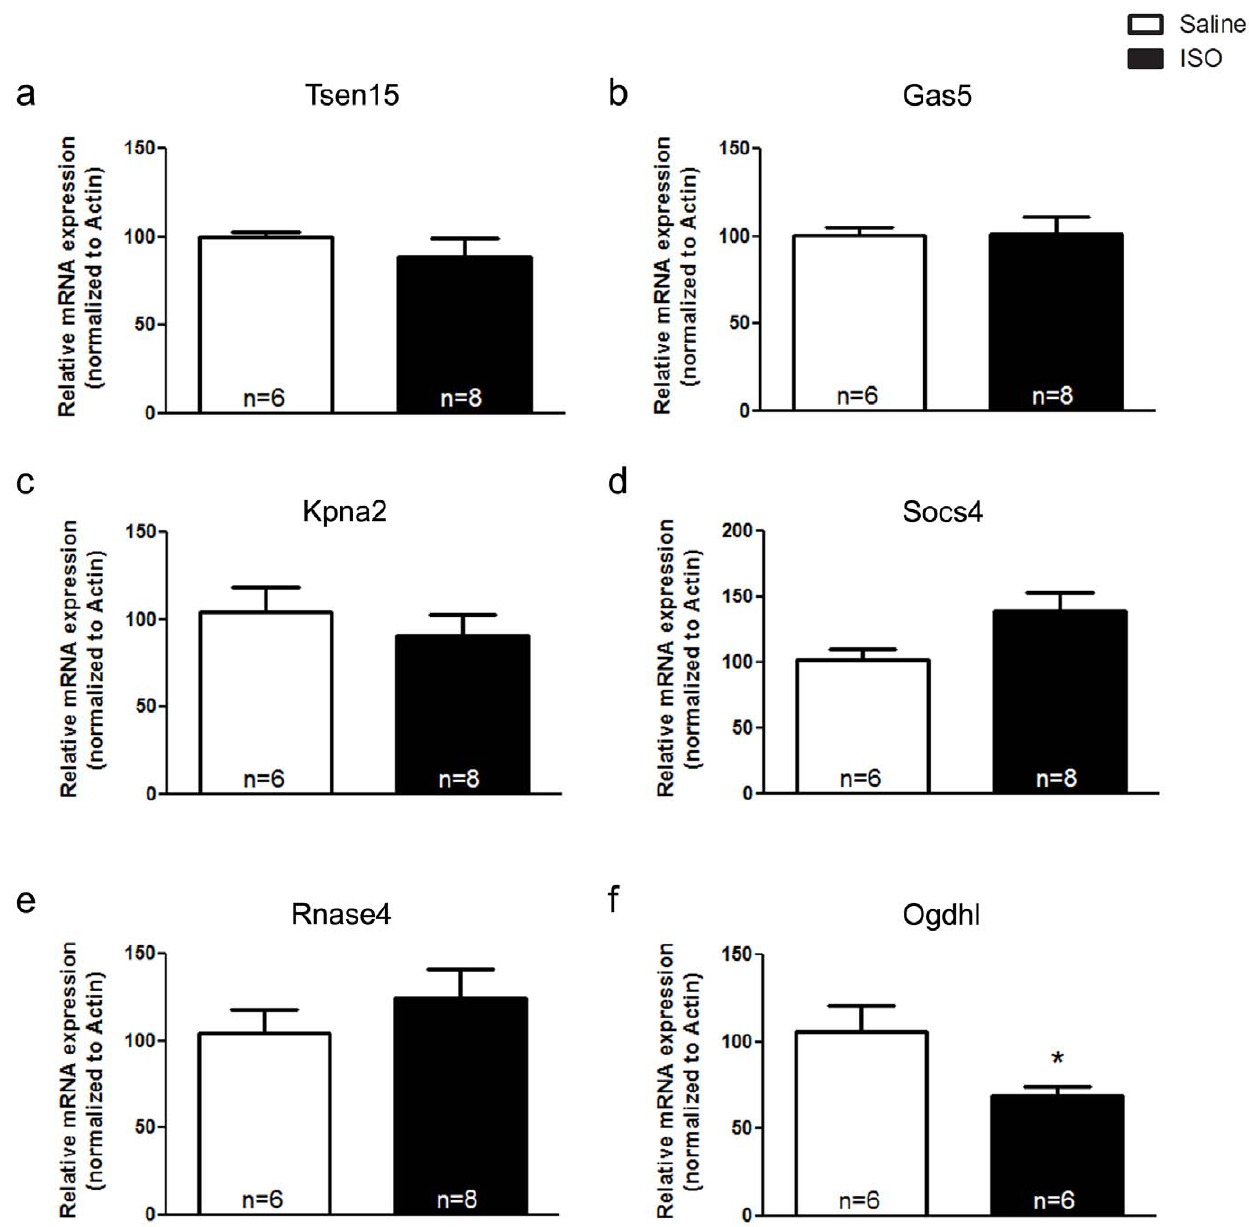
Figure 7. ISO treatment does not lead to the same transcriptional alterations observed in VAChT KD HOM mice. mRNA expression of tRNA splicing endonuclease 3 (Tsen15; panel a ), Growth arrest specific 5 (Gas5; panel b ), karyopherin alpha 2 (Kpna2; panel c ), suppressor of cytokine signaling 4 (Socs4; panel d ), ribonuclease, RNase A family 4 (Rnase4; panel e ) and oxoglutarate-dehydrogenase like (Ogdhl; panel f ) were not significantly altered in the ISO-treated mice as compared to saline-treated controls. Data represent the mean 6 SEM, with n indicated within bars. *p , 0.05 versus wild-type mice.